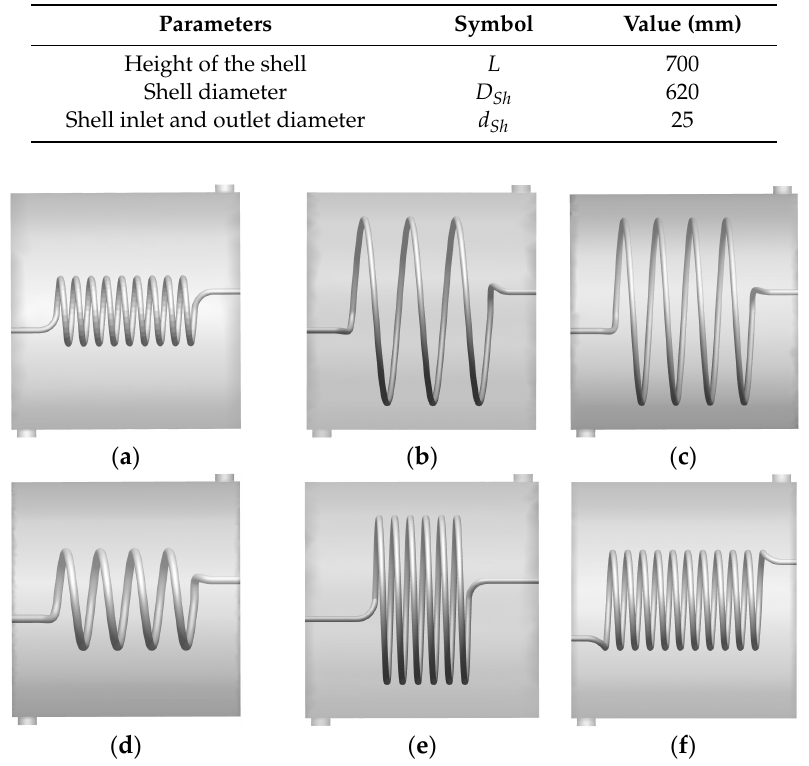
Figure 11. Geometries of the coils used in Cases A to F. ( a ) Case A; ( b ) Case B; ( c ) Case C; ( d ) Case D; ( e ) Case E; ( f ) Case F.